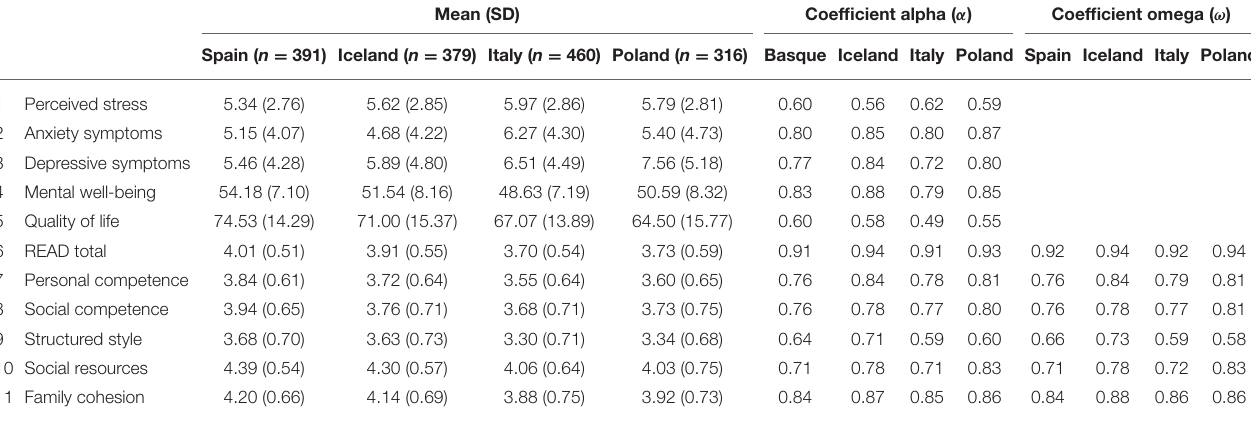
TABLE 3 | Means, standard deviations, and reliability estimates of the Resilience Scale for Adults (RSA) with subscales across all countries ( N =